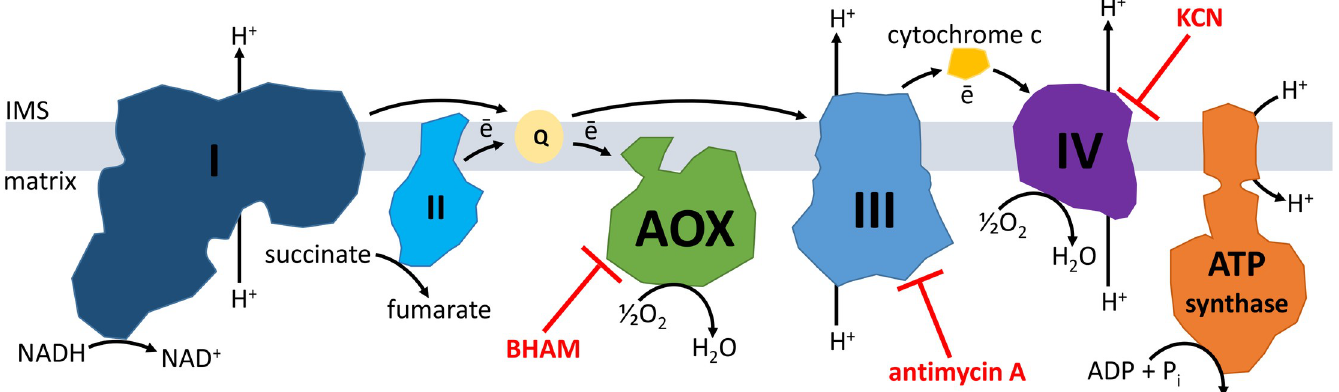
Fig 1. Schematic representation of the respiratory chain in animal mitochondria. The mitochondrial respiratory chain (MRC) in the inner mitochondrial membrane is formed by four main multi-subunit complexes numbered from I to IV. The presence of mitochondrial alternative oxidase (AOX) is postulated for invertebrates with exception of insects and lancelets. Electrons released due to oxidation of metabolites are transported by MRC to oxygen and this generates proton gradient due to proton pumping by the MRC complexes I, III and IV from the matrix to the intermembrane space (IMS). The proton gradient is then used among others to feed ATP synthesis by the ATP synthase. AOX introduces a branch into MRC localized at the ubiquinone/ubiquinol (Q) pool. This results in transferring of electrons to oxygen with sustained proton pumping by the MRC complex I, but without proton pumping by the MRC complexes III and IV, the latter forming together the MRC cytochrome pathway. BHAM, antimycin A and KCN are known inhibitors of AOX, the MRC complex III and IV,